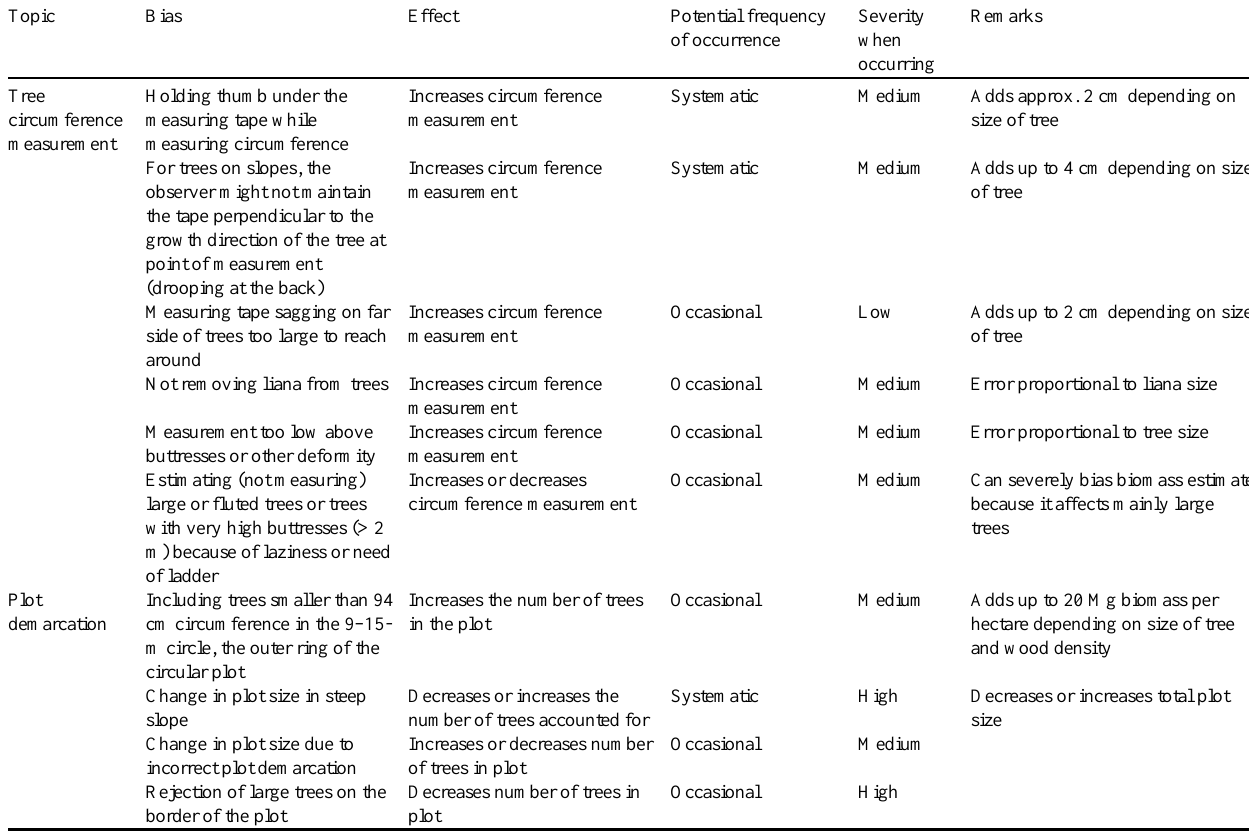
Table 4 . Identified plot level biases in the measurement of aboveground forest biomass by community members and professional foresters, with notes on possible effects and severity of these